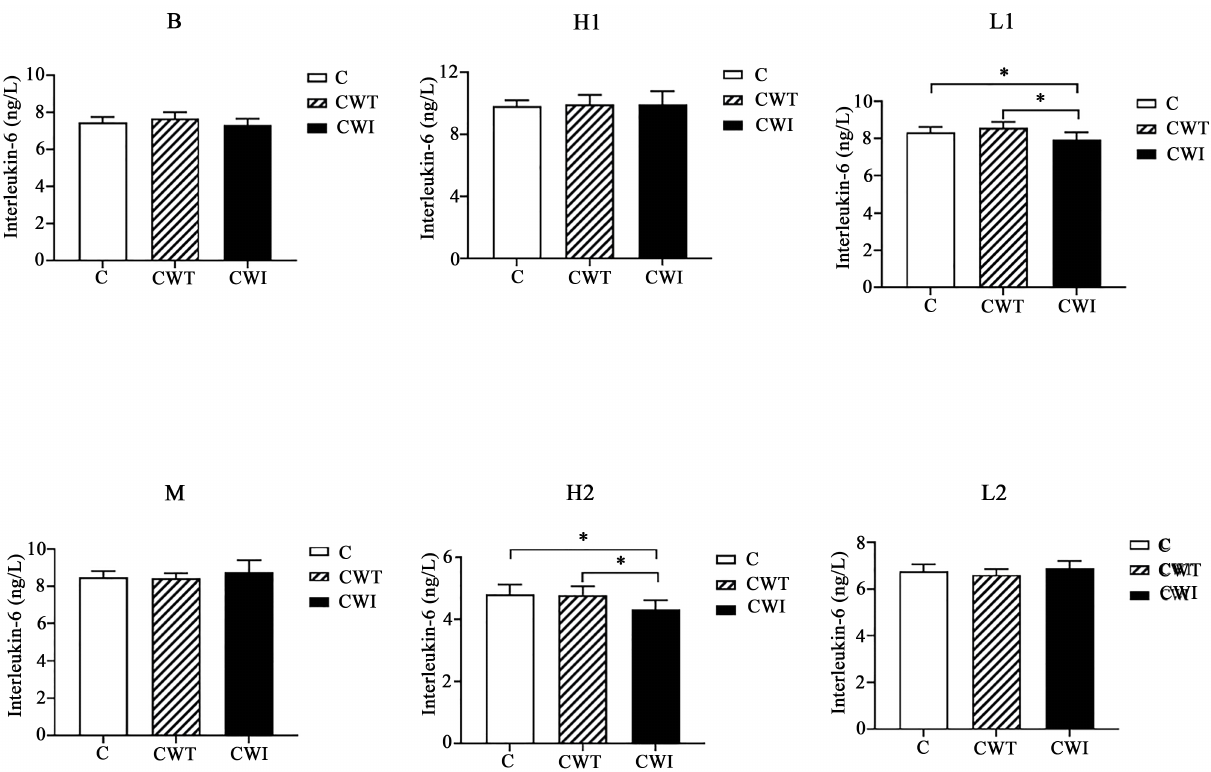
Fig. 2. Serum interleukin 6 level in each group. * p < 0.05, # p < 0.05 represent the difference between CWI and CWT at the same time